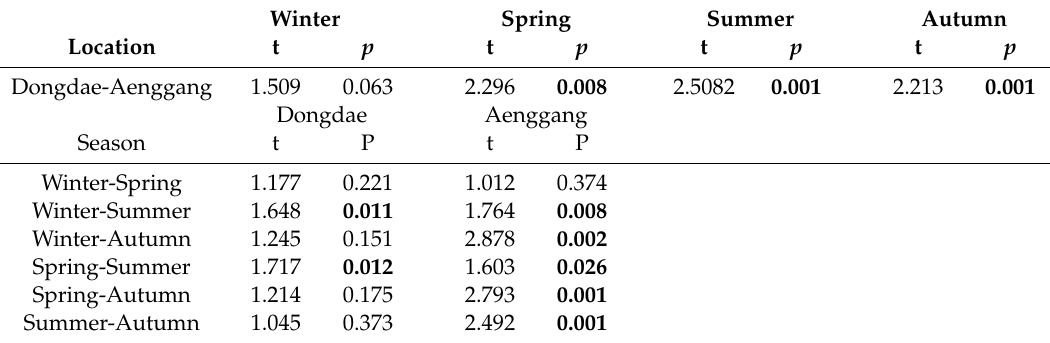
Table 4. Pairwise PERMANOVA tests for the location–season interaction within each study location, or season; bold letters indicate significance at p <